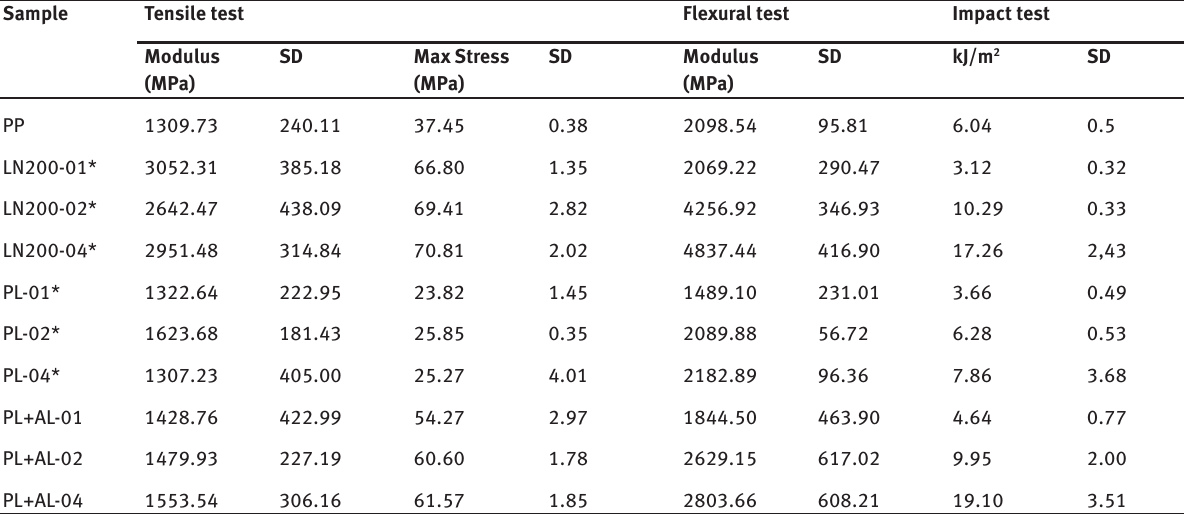
Table 2: Mechanical properties of BANTEX composites. Sample Tensile